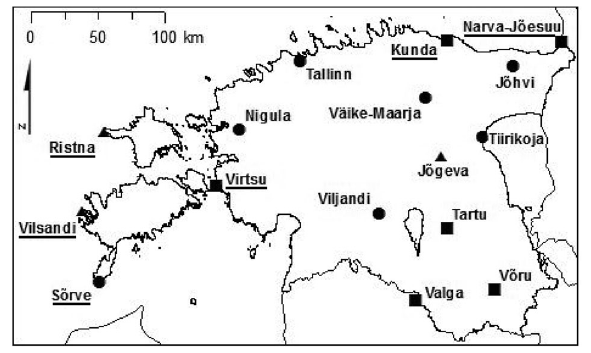
Fig. 1. Locations of meteorological stations in Estonia used